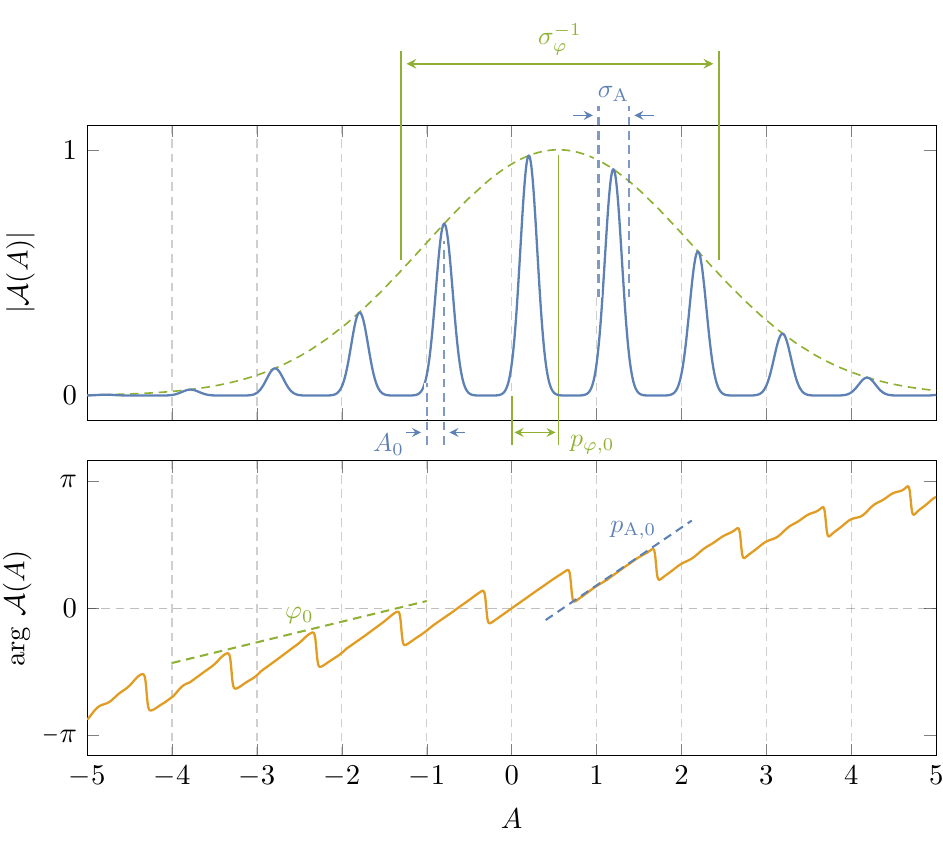
Figure 7. The magnitude and phase of a well-localized Gaussian state in the gauge (cid:12)eld frame. As detailed in the main text, the wavefunction’s small (large) scale structure determines the gauge (axion) (cid:12)eld’s